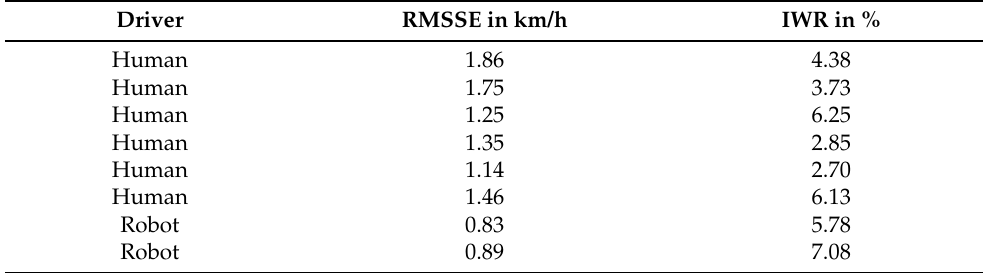
Table 6. Determined WLTC limit values for selected test runs.